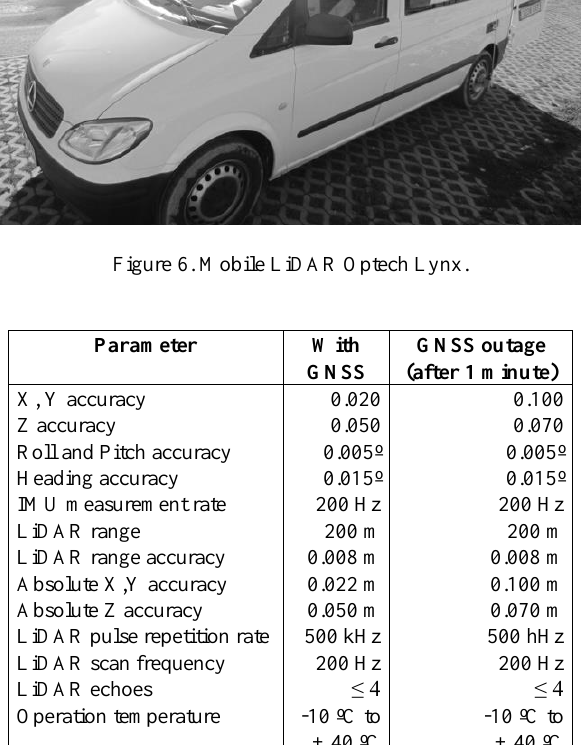
Table 2. Technical specifications of Optech Lynx mobile